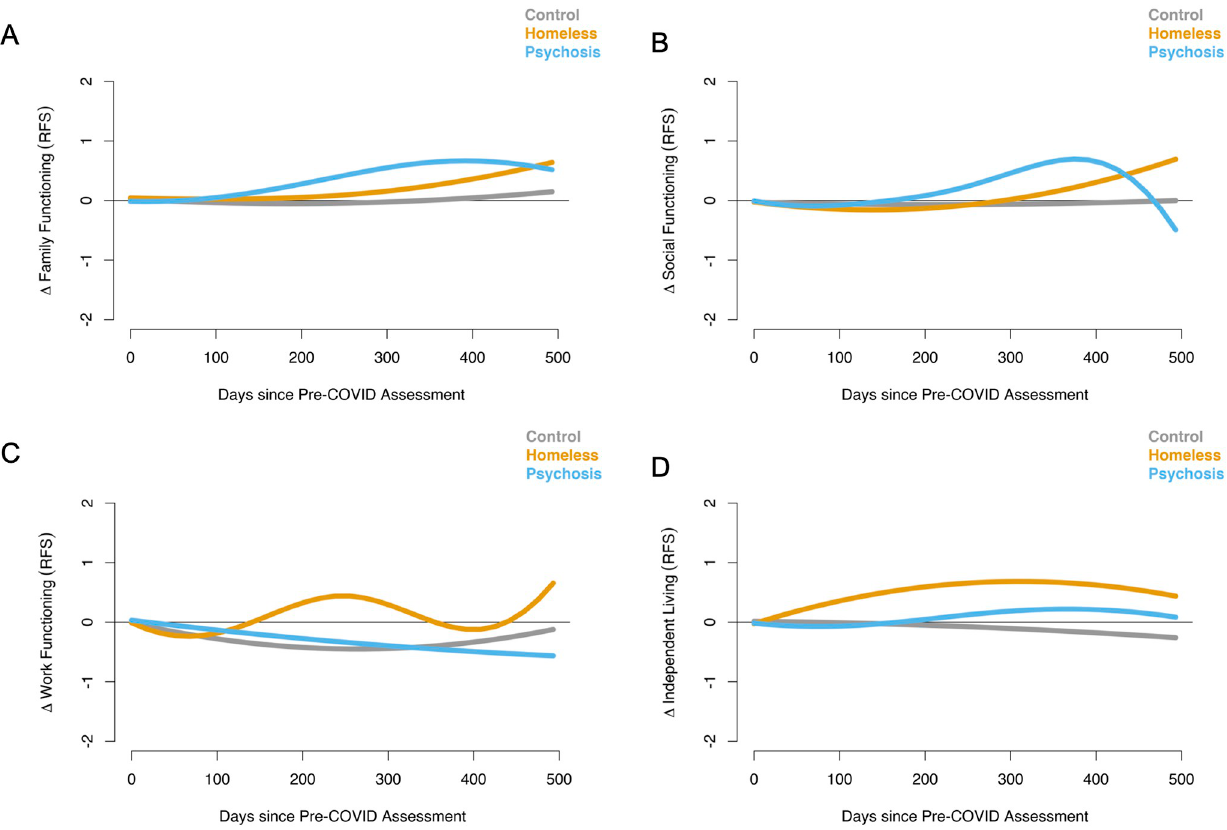
Fig 2. Results for the GAM analyses of community integration outcomes. The smoothed curves represent the change over time in trajectories for controls (CTL; gray), recently housed Veterans (RHV; yellow), and Veterans with psychosis (PSY; blue). In all cases, higher scores indicate better functioning. The panels show results for A) family functioning, B) social functioning, C) work outcomes, and D) independent living.